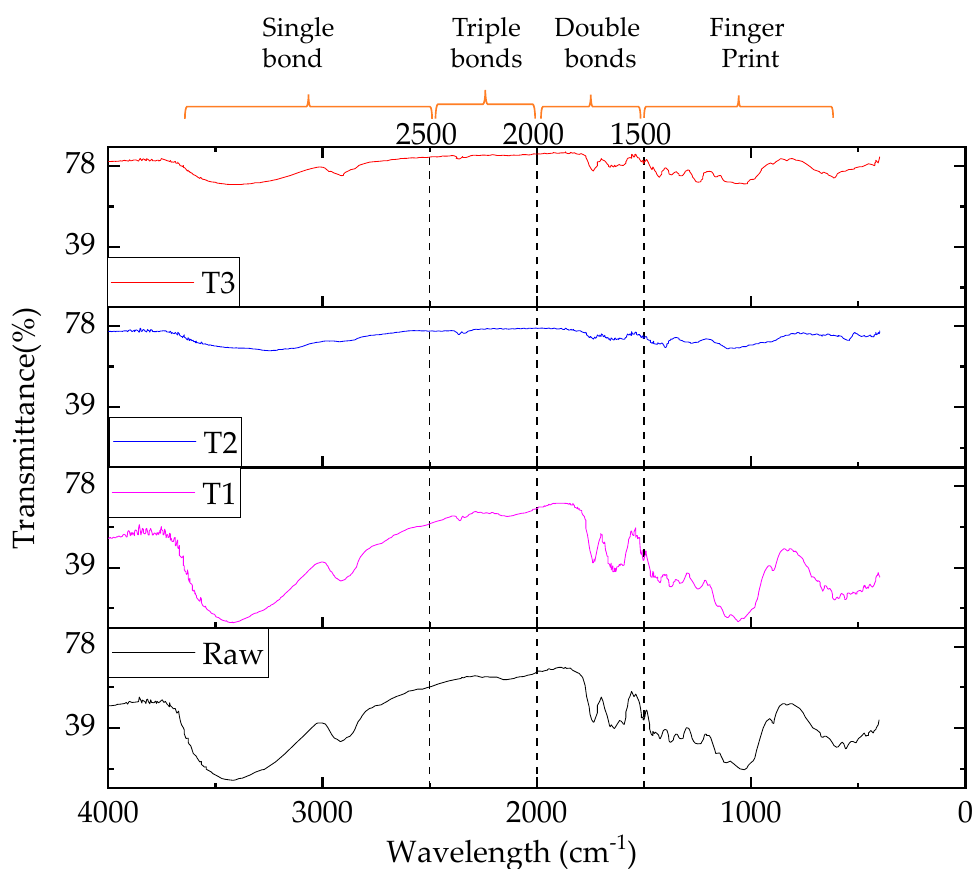
Figure 8. FTIR-transmittance spectra and bond regions of raw and treated jute fibers (T1: Rot retardant, T2: fire retardant, and T3: water retardant).